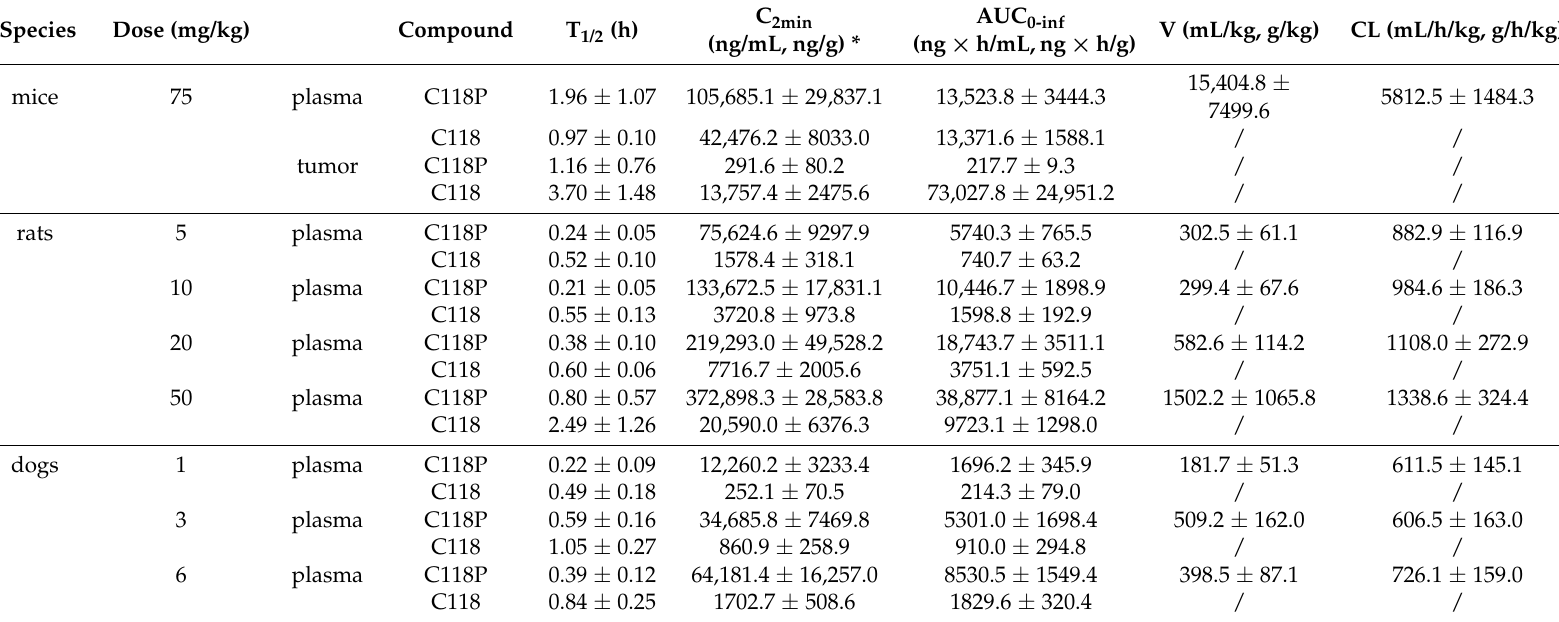
Table 3. Pharmacokinetic parameters of C118P and C118 in nude mice, rats and dogs after intravenous injection of C118P ( n = 4 for nude mice and n = 6 for rats and dogs, mean ±